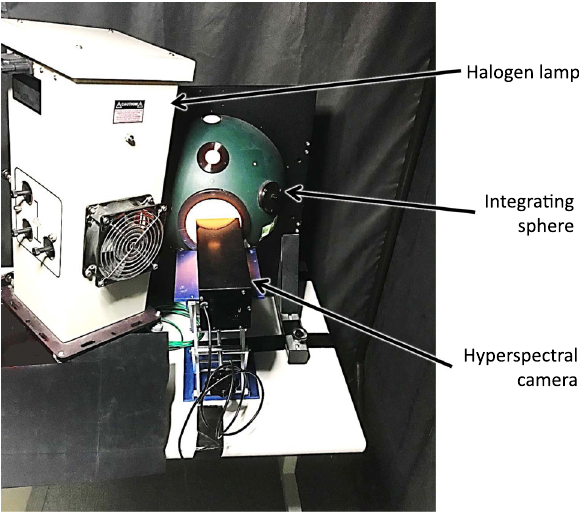
FIG. 8. Setup of the pixel sensitivity calibration using an integrating sphere. Photograph courtesy of EBA JAPAN Co., Ltd.